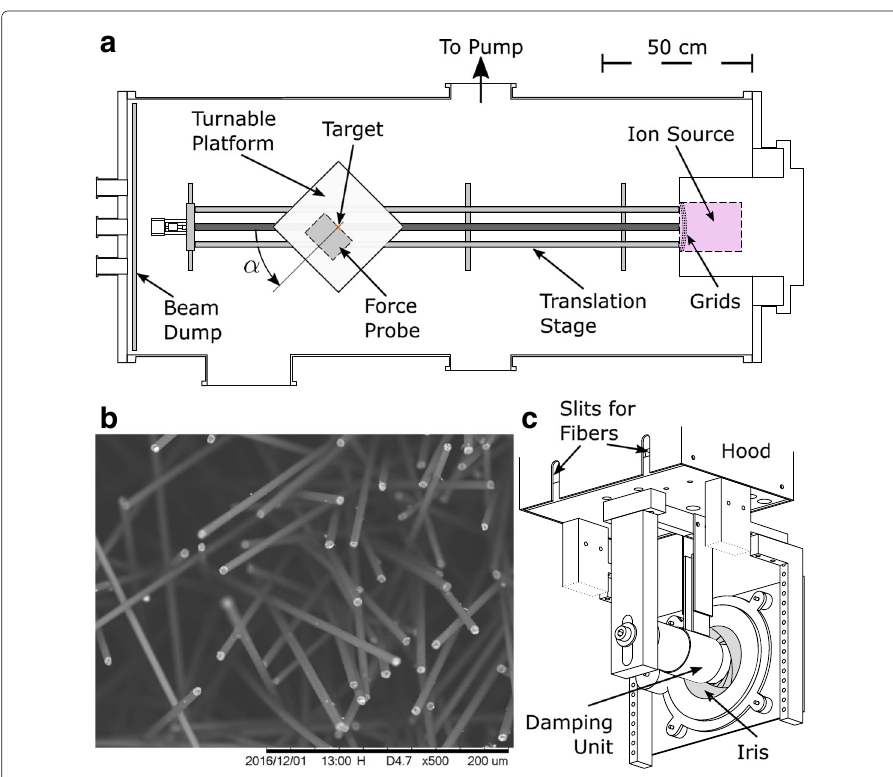
Fig. 6 Application of the force probe. a Top view of the vacuum chamber used for the example measurements. The tilt angle α indicates the rotation of the platform with the force probe. This angle is the angle of incidence of the ions emitted from the ion source that impact at the force probe target. b Scanning electron microscopy image of the carbon fiber velvet. c Force probe with beam shutter. The drawing shows the setup with the blade iris half open (gray shaded) from behind. (This optional device is not used in the example measurements)